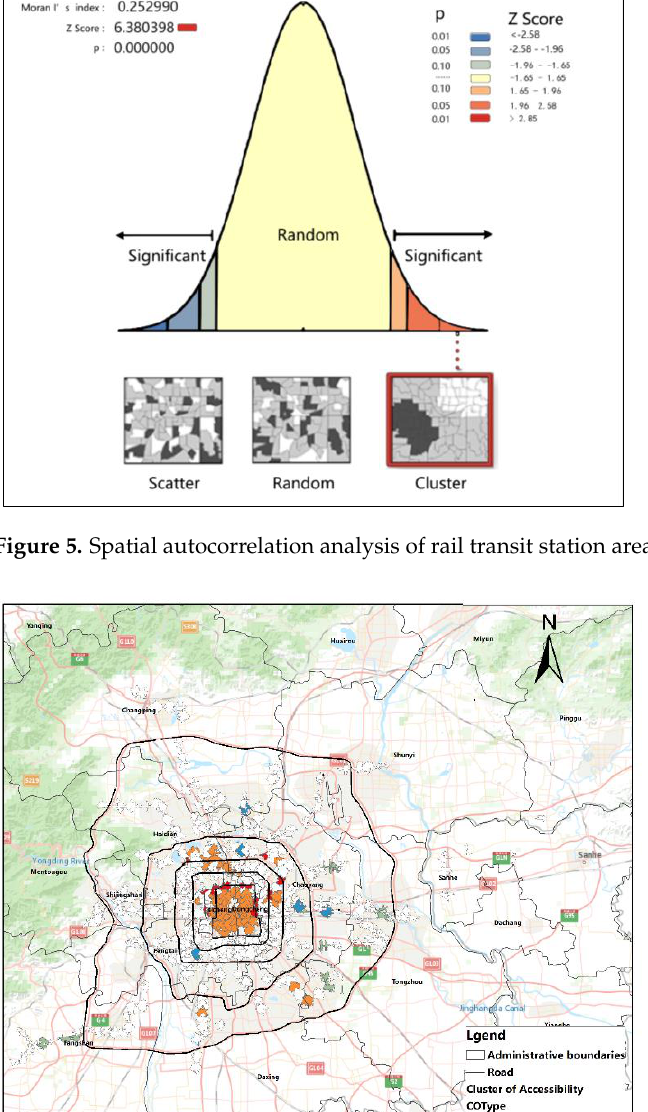
Figure 5. Spatial autocorrelation analysis of rail transit station area accessibility.